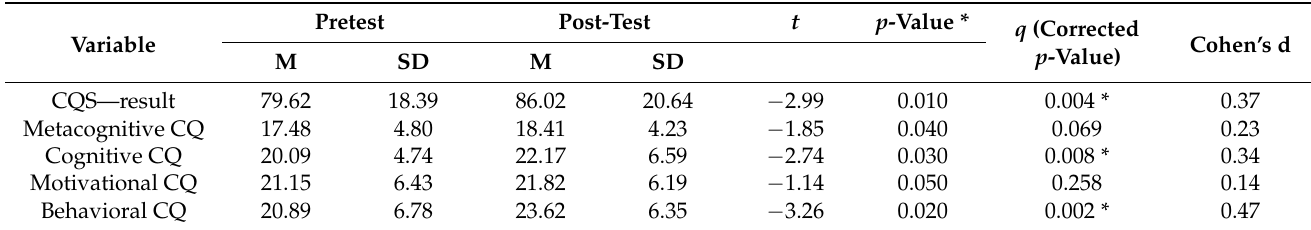
Table 3. Overall results of CQS and subscales of nursing students in 2020 (study 2).